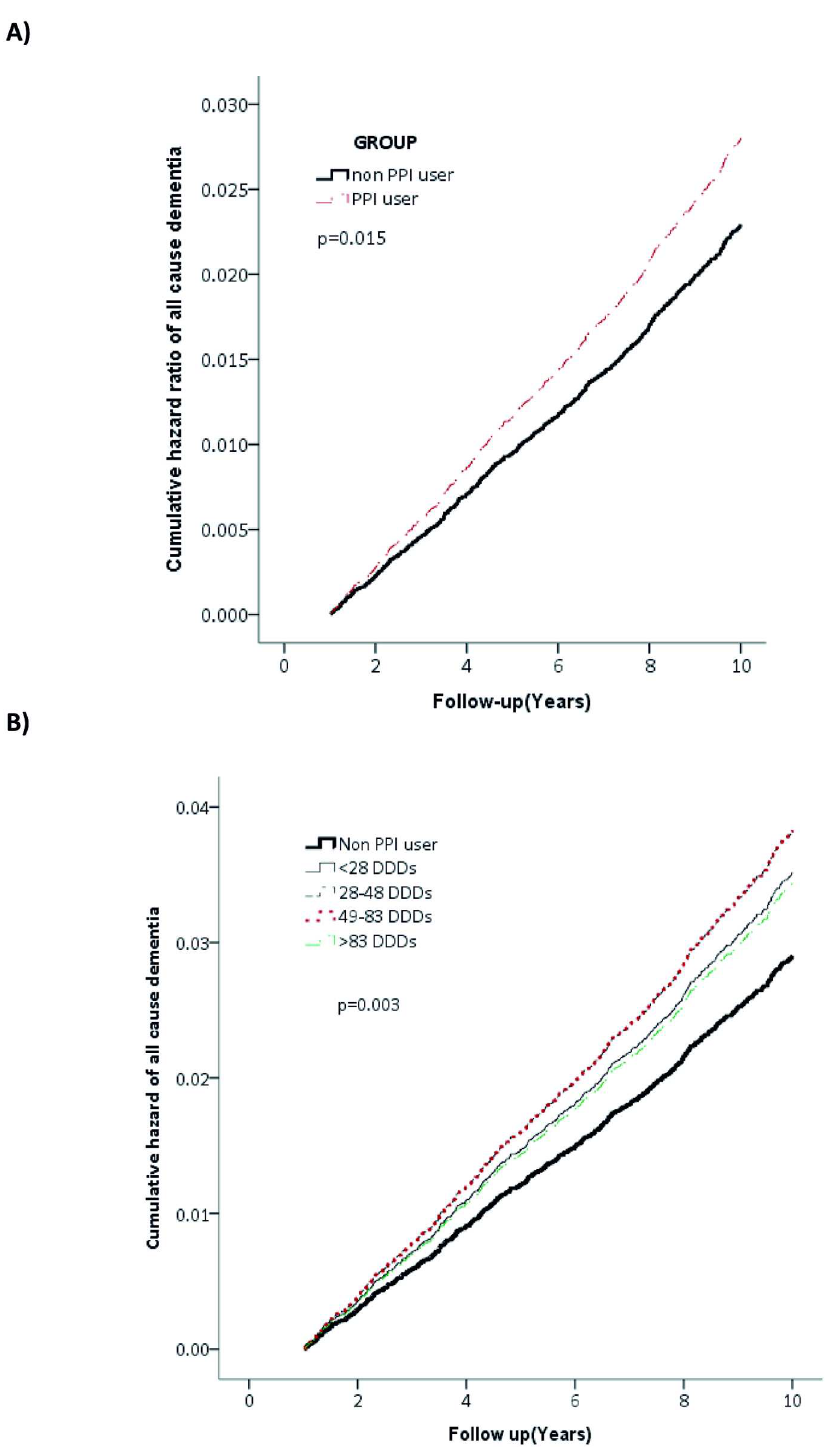
Fig 2. All-cause dementia by A) use and B) defined daily dose (DDD) of proton pump inhibitors (PPIs).